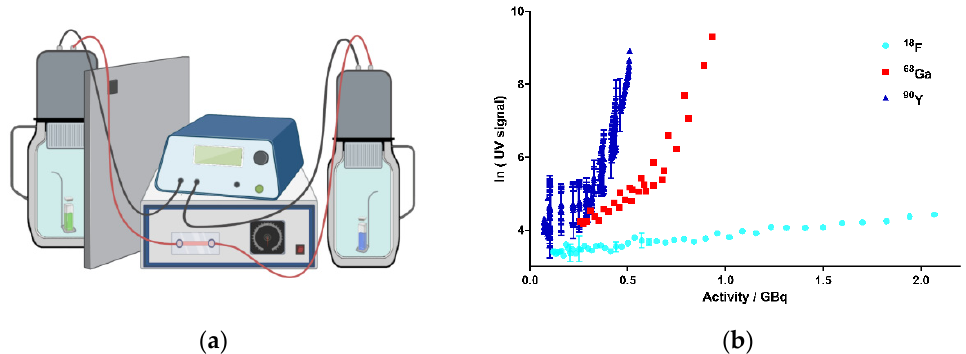
Figure 2. Activity ‐ dependent generation of CR by the decay of 18 F, 68 Ga, and 90 Y in kamiokanne (KK) experiments. ( a ) Schematic test setup of KK experiments. Two thermos flasks separated by a lead wall were filled with water together with a holder for a sealed quartz cuvette containing the samples. The flasks were equipped with photomultiplier tubes (PMTs) and electronic devices to detect CR. The green cuvette represents a solution of the radionuclide sample, and the blue sample illustrates the negative control containing the solvent without radionuclides. On top of the thermos flasks, PMTs were attached to high ‐ voltage supplies (figure created with BioRender.com). ( b ) Results from the KK experiments. The activities of the three radionuclides, 18 F, 68 Ga, and 90 Y, are presented individually for each experiment in correlation to the resulting Cherenkov signal intensity (UV signal). The signal strength corresponds to the number of signals at 10 ‐ minute intervals. Signals of cosmic radiation were used to determine the baseline (blank value). Each radionuclide was tested in three independent experiments; data represent mean ± SD.